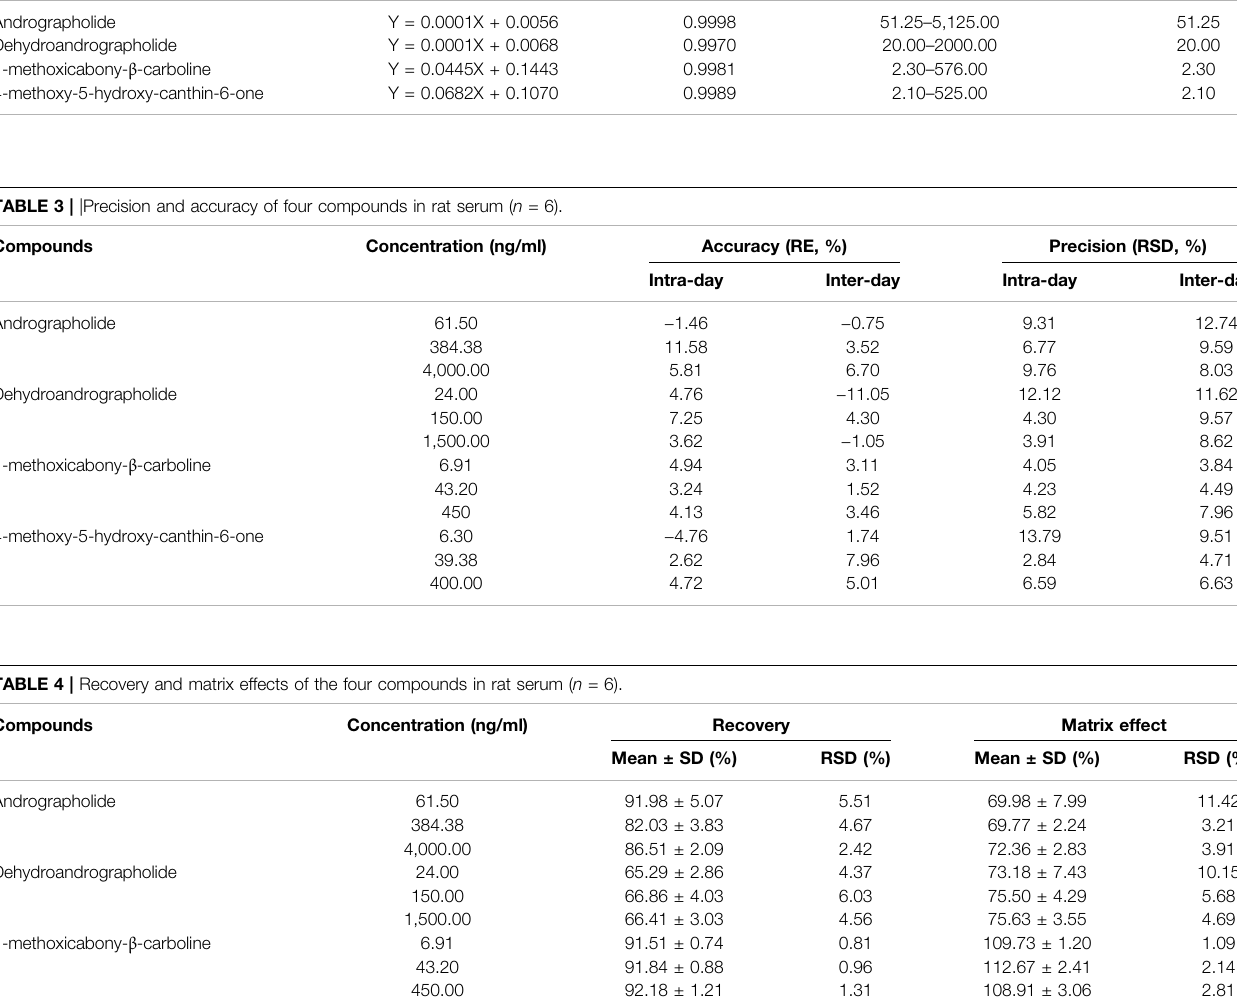
TABLE 2 | The details of the regression analysis of four compounds in rat serum. Compounds